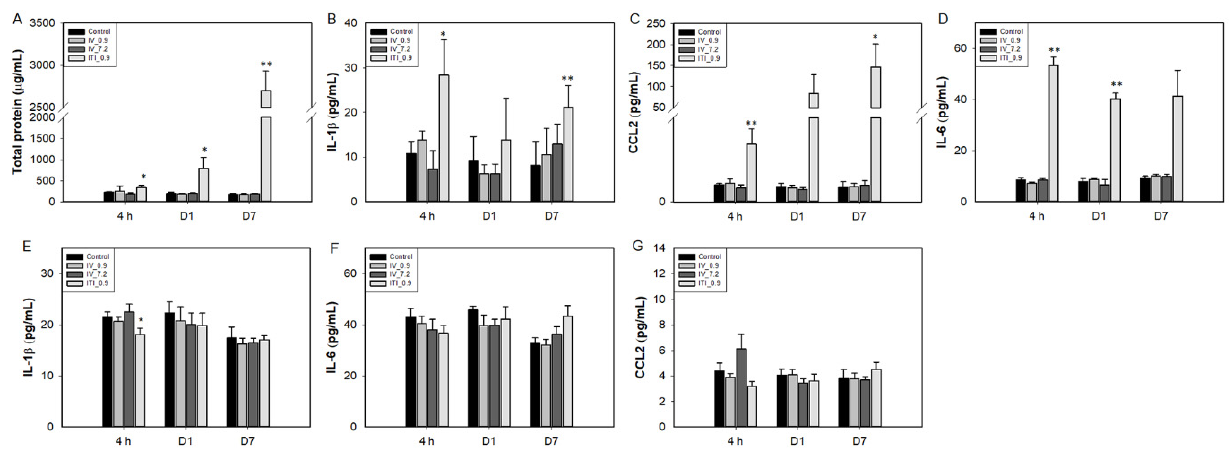
Figure 4. Changes in cytokine levels in the BAL fluid ( A – C ), lungs ( D ), and liver lysates ( E – G ) of PHMG-P-treated mice. Bars represent the mean ± standard deviation ( n = 5 per group). Values are significantly different from the control group: * p < 0.05, ** p < 0.01.